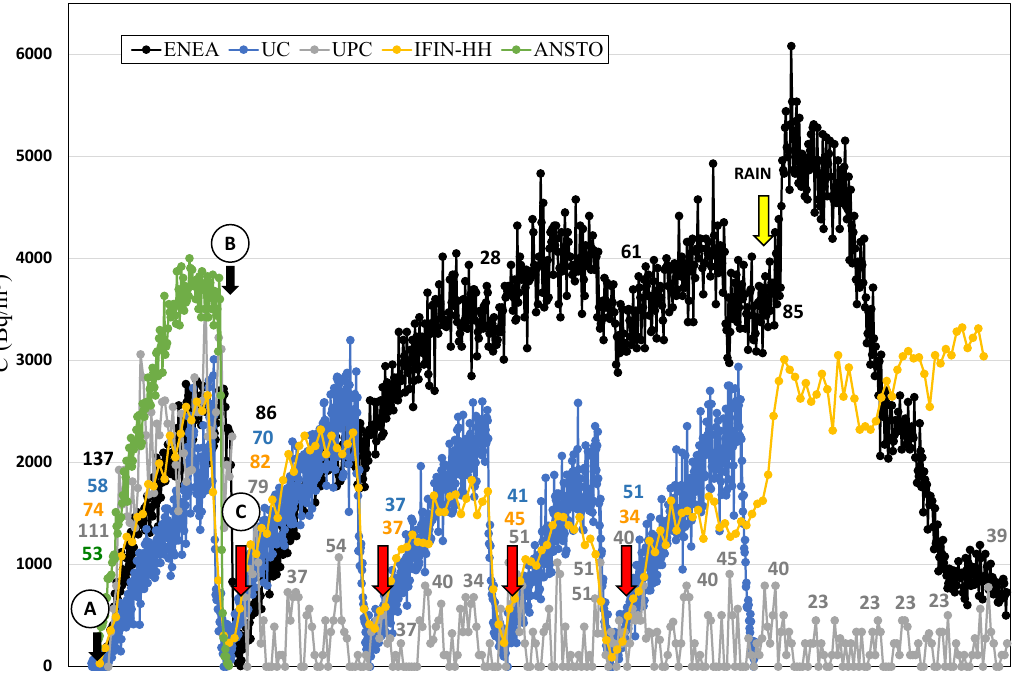
Figure 11. Radon activity concentration over time measured during the low radon flux campaign first week. Colored numbers indicate the radon flux (Bq m − 2 h − 1 ) calculated by linear fit for each corresponding system.